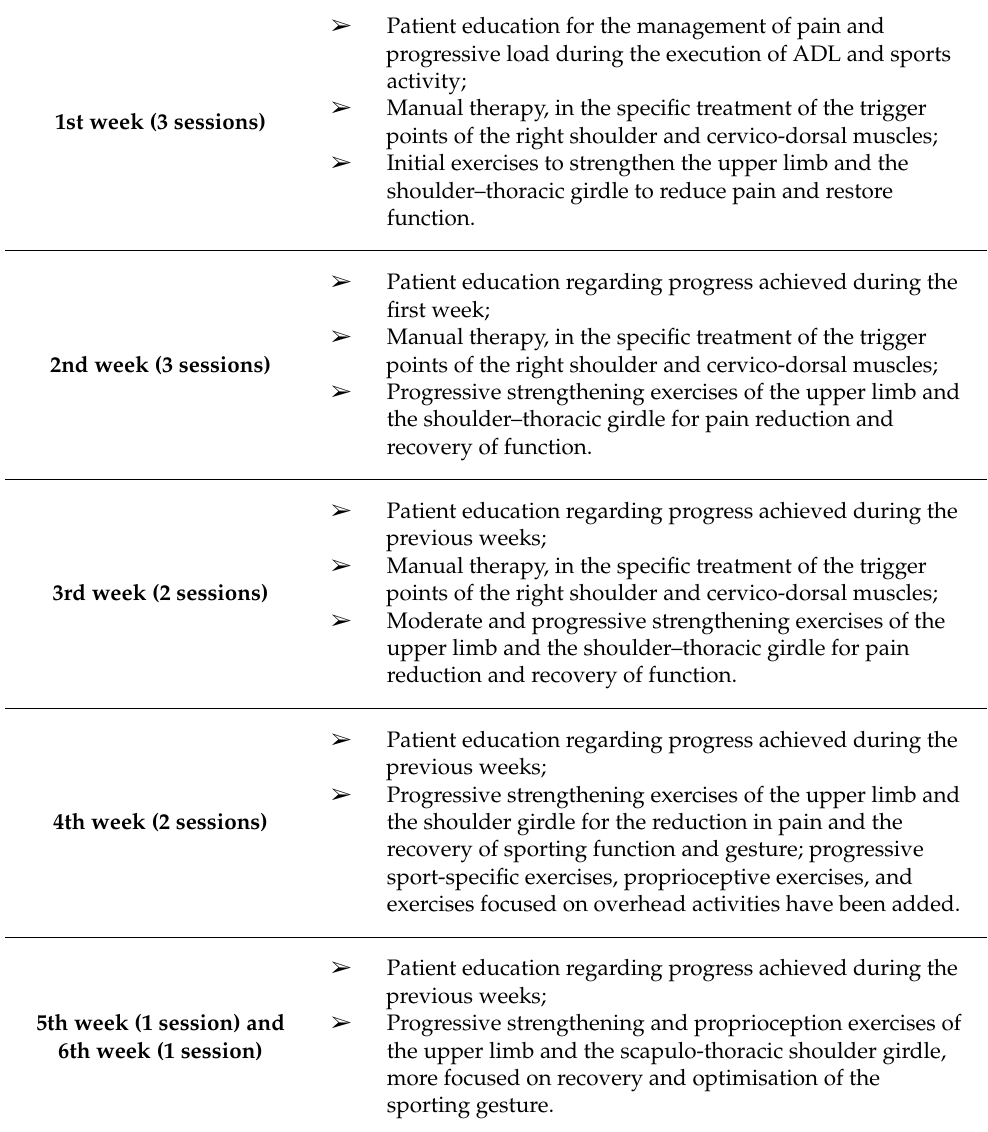
Table 1. Rehabilitation